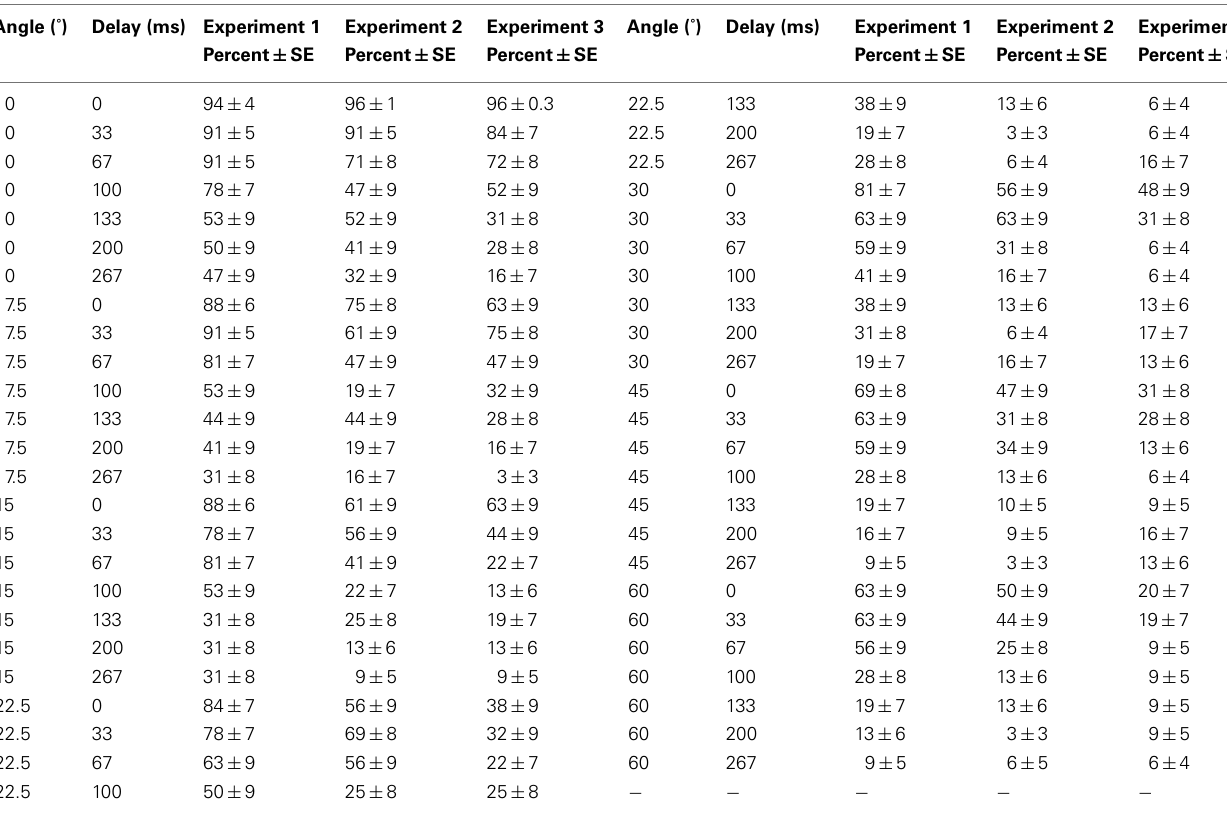
Table 2 | Percent of parameter combinations judged causal by